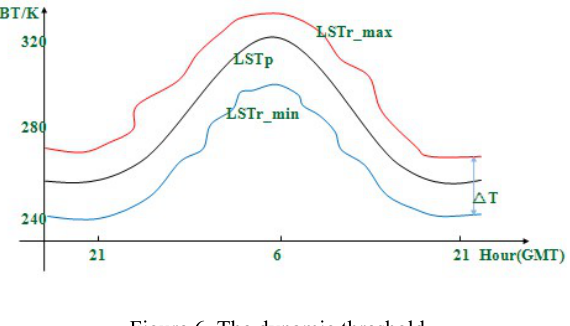
Figure 6. The dynamic threshold